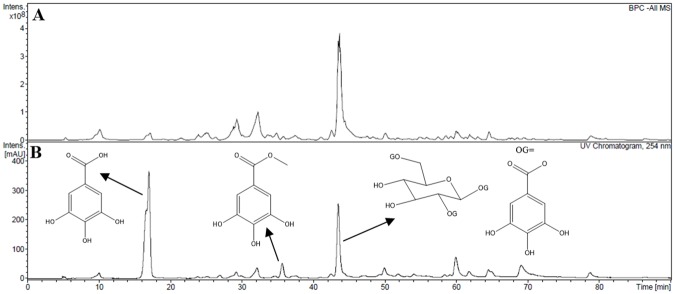
Base peak chromatograms (BPC) in negative ion mode (A) and DAD chromatogram at 254 nm (B) of ethyl ether fraction from leaves of D. vandellianum by HPLC-DAD-ESIMSn.In (B), the peaks corresponding to gallic acid, methyl gallate and 1,2,6-tri-O-galloyl-β-d-glucopyranose was demonstrated.